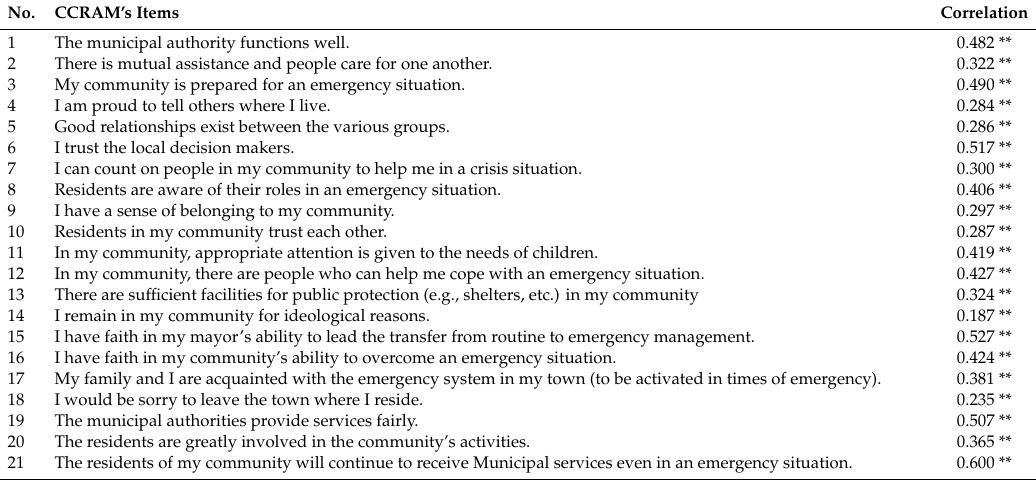
Table A3. Correlation between CCRAM items and confidence in health services